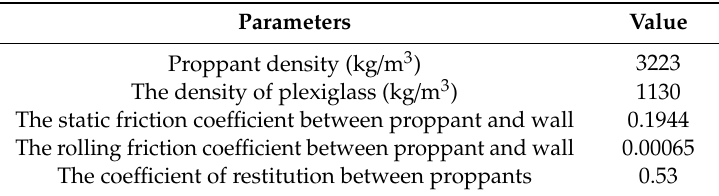
Table 4. Parameters for the simulation.